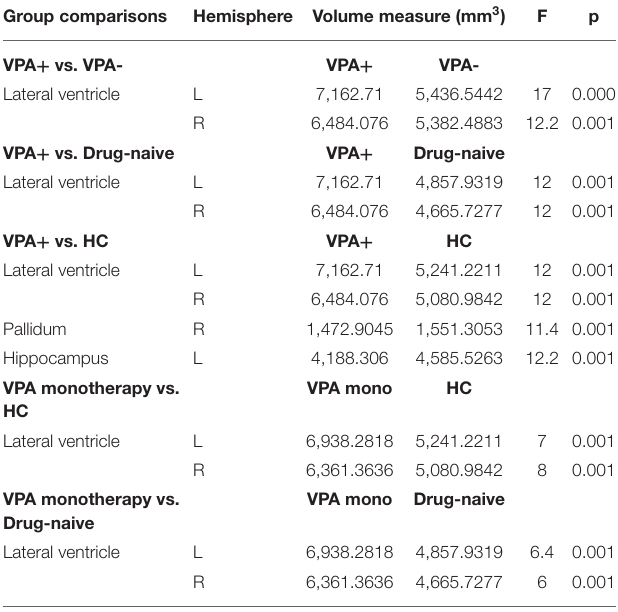
TABLE 3 | Significant results from subcortical structure analyses. Group